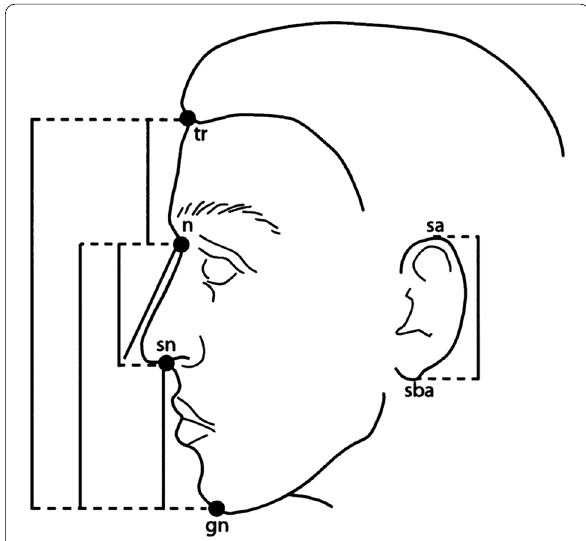
Fig. 1 Measurements of the lateral aspect of the face: upper face height two (tr-n); total face height (tr-gn); morphological face height (n-gn); nasal height (n-sn); ear length: sa-sba (Farkas et al. 2005)